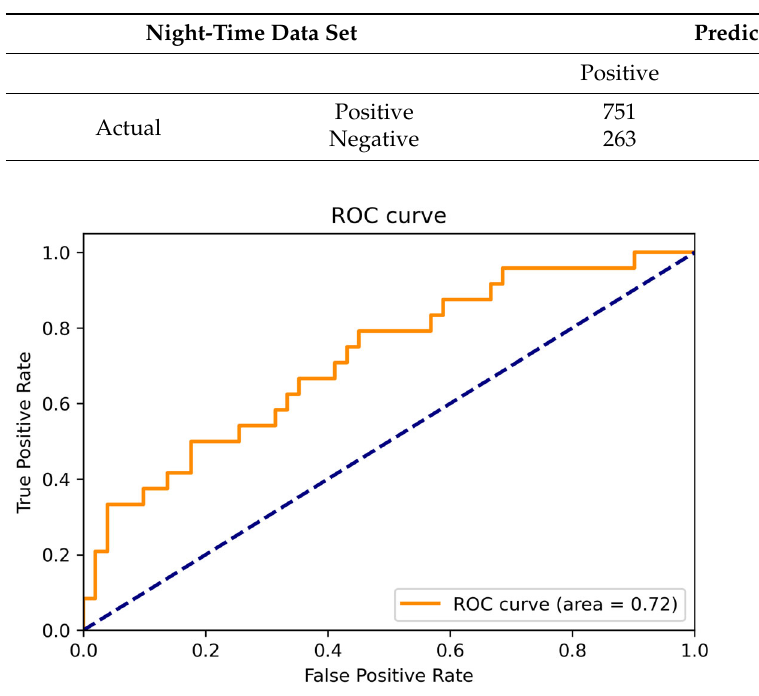
Figure 24. ROC curve of the data set.